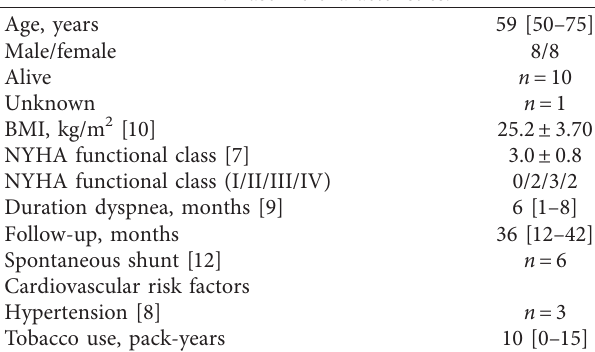
Table 2: Baseline